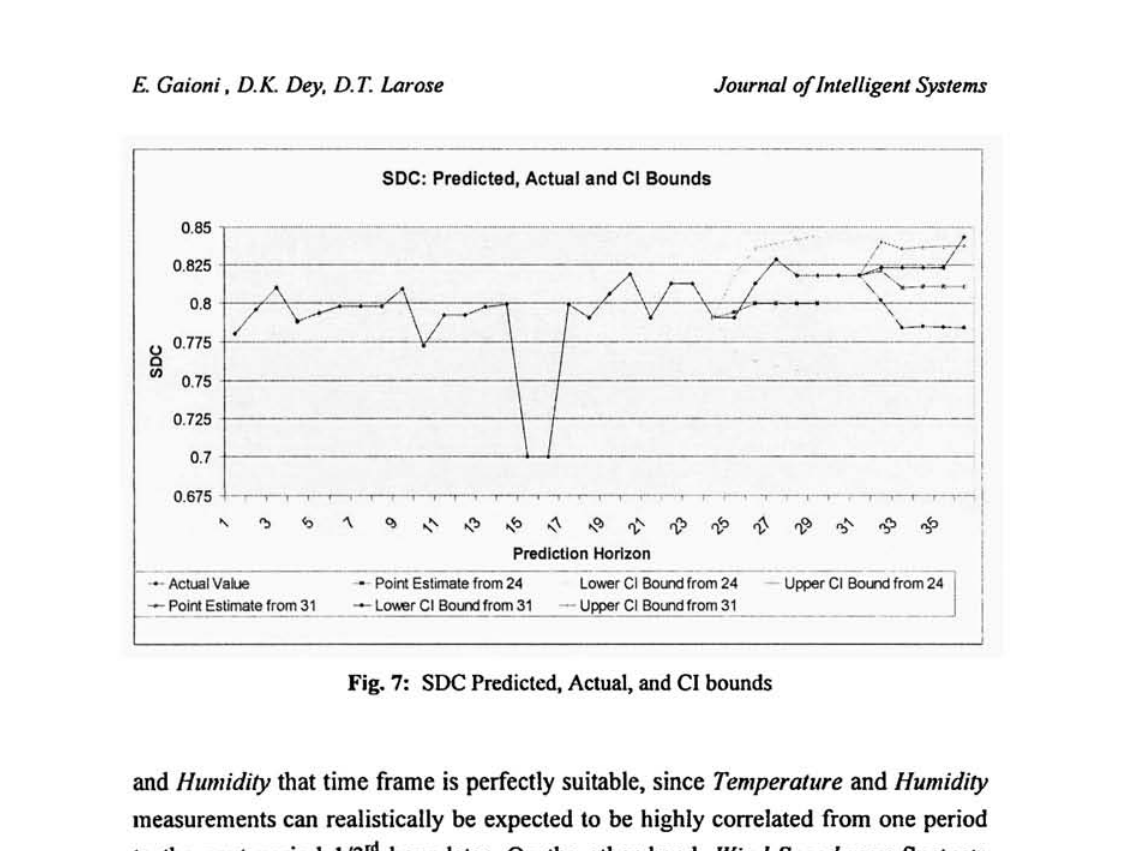
Fig. 7: SDC Predicted, Actual, and Cl